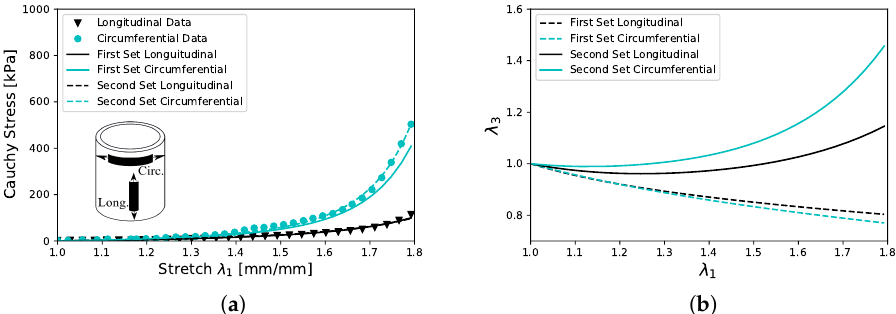
Figure 4. Material responses obtained with unstable and stable model parameters. ( a ) Tensile test; ( b ) Transversal Stretch λ 3